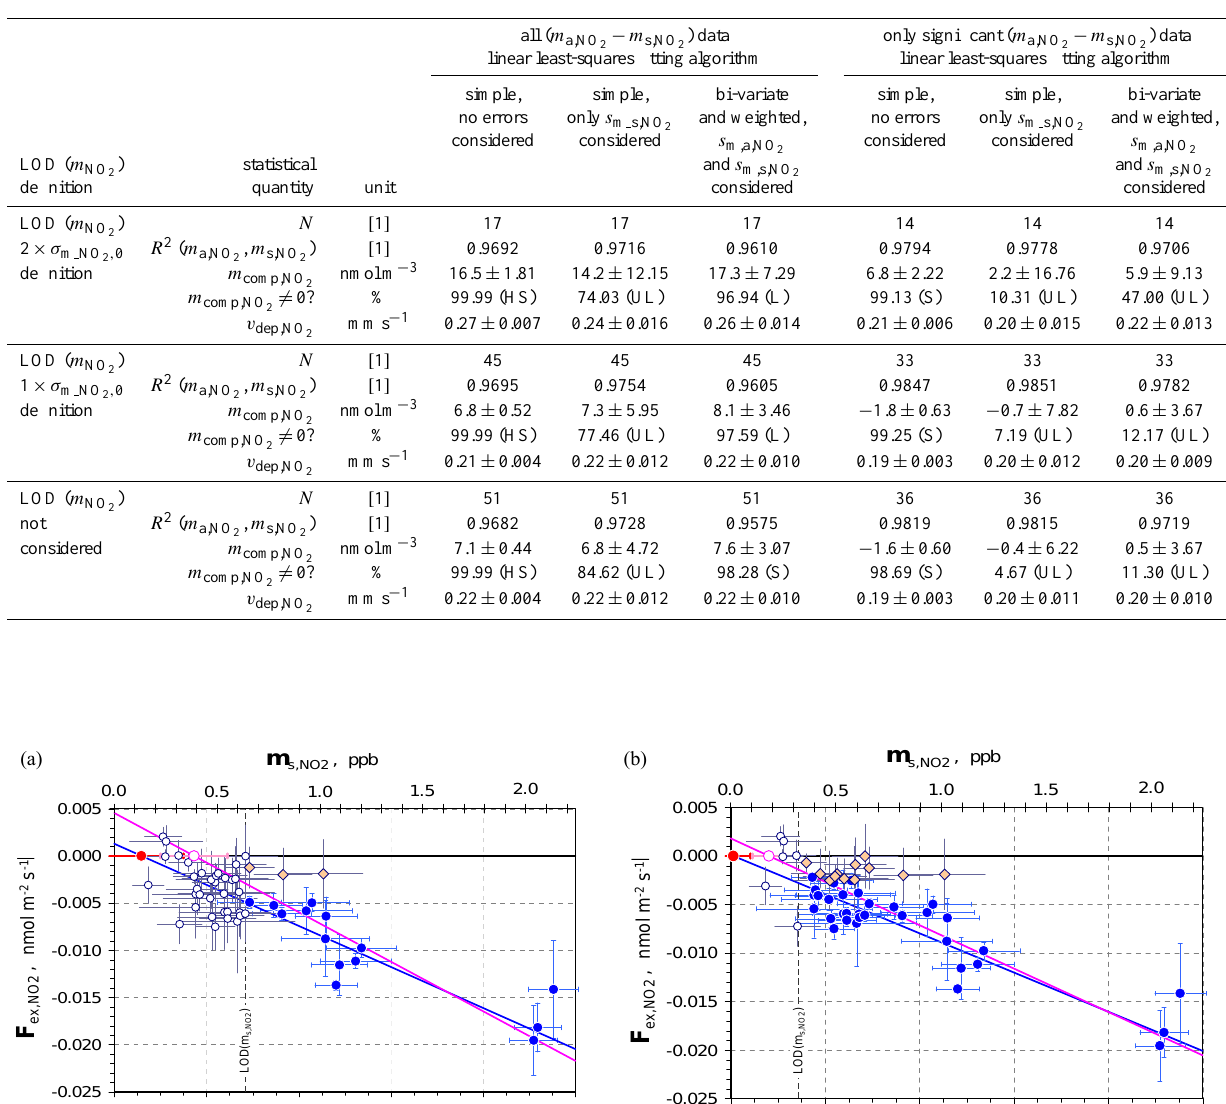
Table 7. Parameters of NO 2 laboratory measurements of simple (no errors considered), simple (standard error of m s,NO bi-variate weighted (standard error of m s,NO and m a,NO considered) linear least-squares fitting regression analysis. Data were separated 2 2 − m for all data of 1m NO =( m a,NO s,NO 2 ) and for only significant data of 1m NO 2 . Limit of detection (LOD) of 2 σ , 1 σ and no LOD was 2 2 applied to the data.